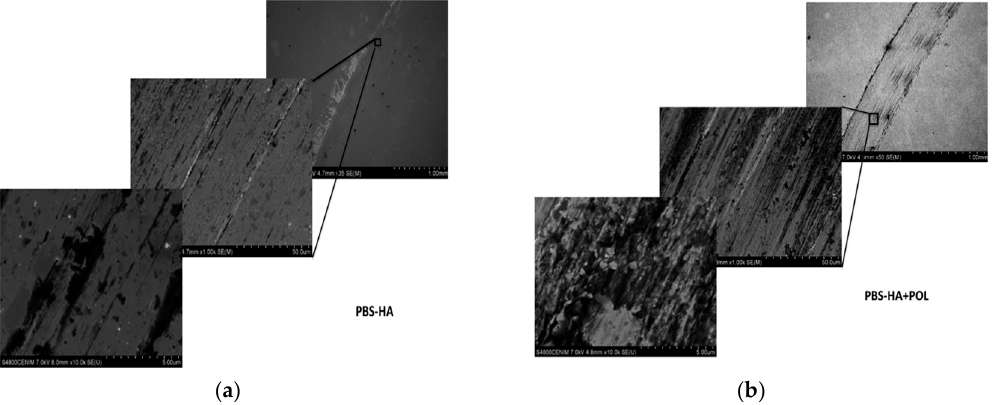
Figure 3. Secondary electron images of wear tracks on HCCoCr disks. Images by SEM of HCCoCr samples in PBS-HA under wear: ( a ) at the open circuit potential (PBS-HA) and ( b ) applying anodic potentiodynamic polarization (PBS-HA+POL).